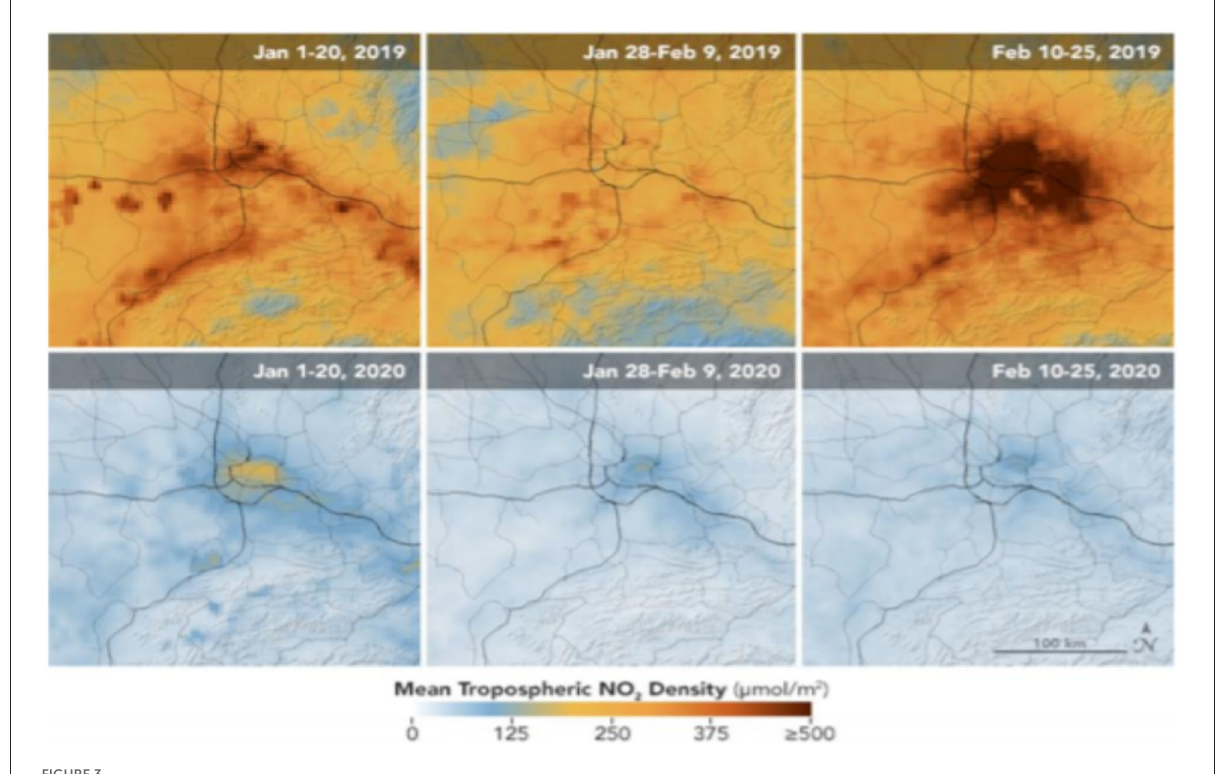
FIGURE3 Changes in NO 2 emissions in Wuhan, China. Source: NASA